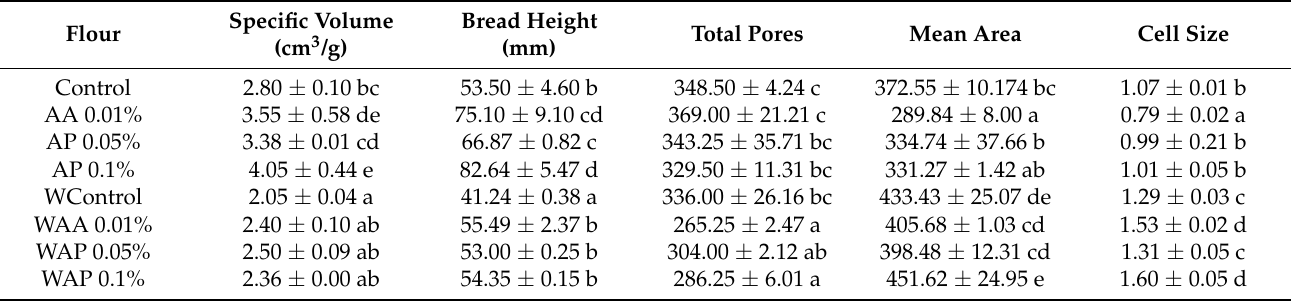
Table 2. Bread specific volume and image analysis.